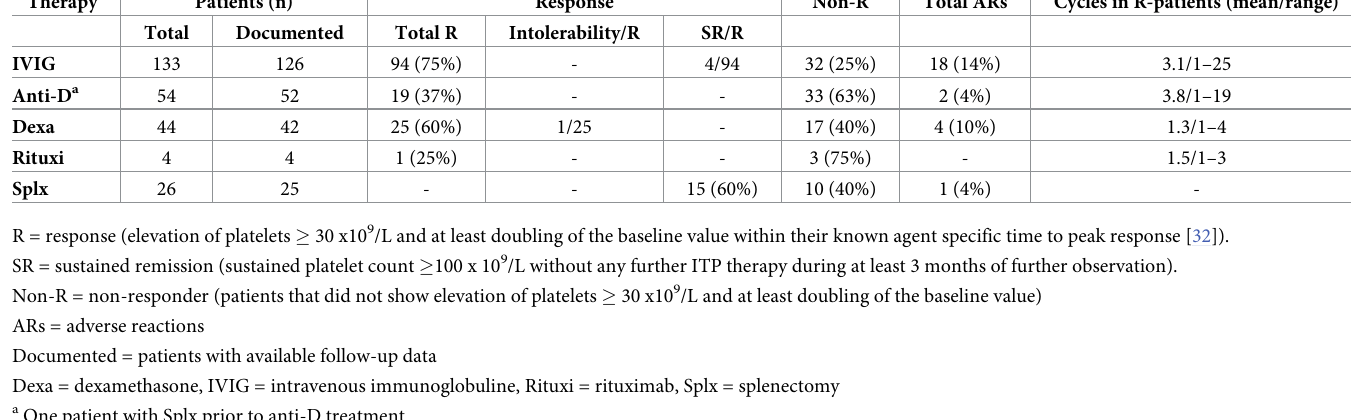
Table 1. Results of short-course treatments in patients with ITP during observation at our institution (n = 190). Therapy Patients (n)